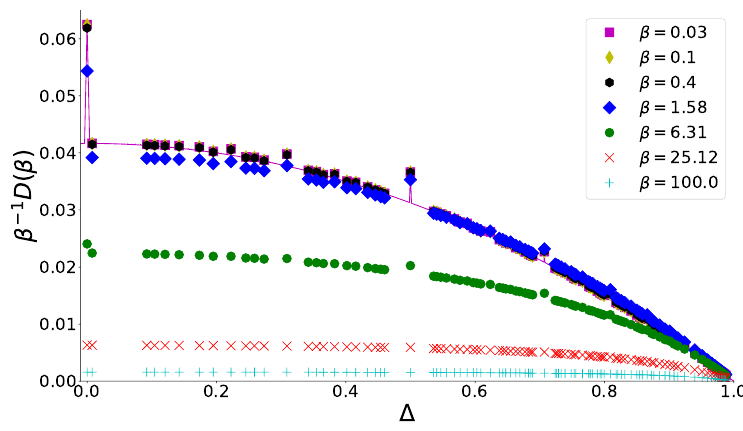
Figure 1: Drude weight coefficient β − 1 D ( γ , β ) for various anisotropies γ = π n / m and temperatures. Note that the high temperature results ( β = 0.4,0.1,0.03) are partly on top of each other on this scale and agree with the analytical infinite temperature result (solid line). D ( β ) is a nowhere continuous function except for at β − 1 = 0. Note that the change of β − 1 D with decreasing temperature is not uniform: the data for β = 0.4 and β = 1.58 show a crossover at cos ( γ ) = ∆ ≈